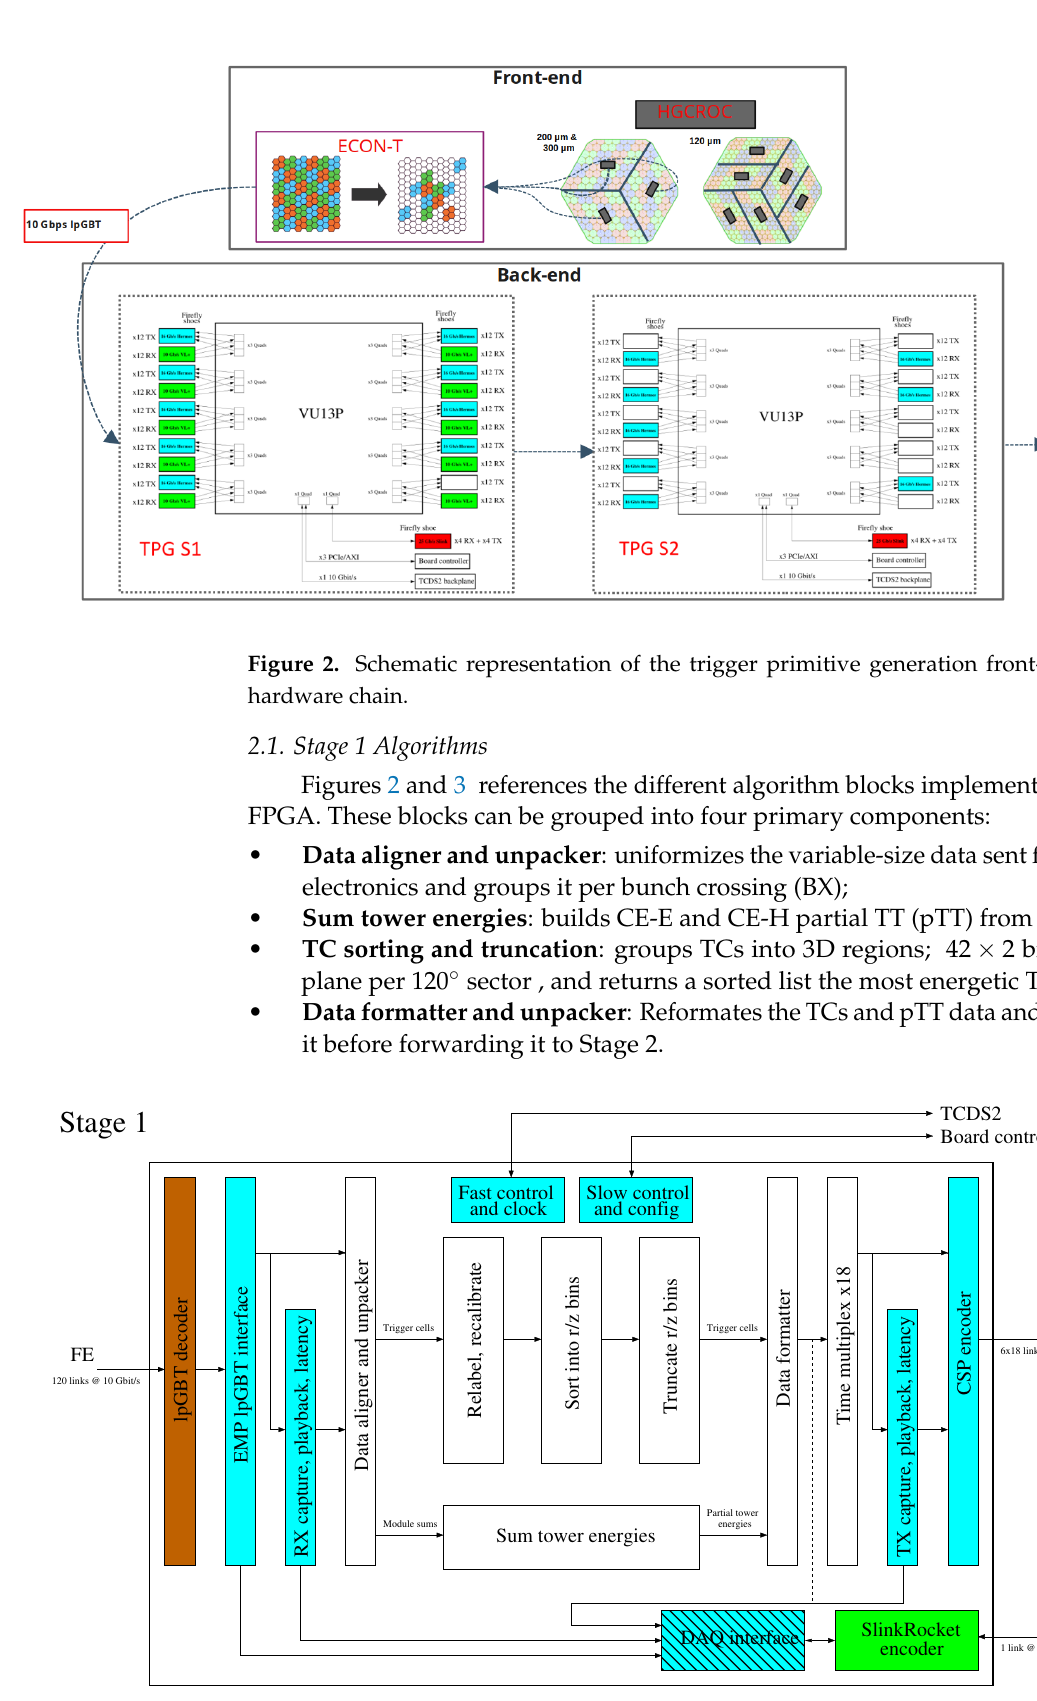
Figure 3. Schematic view of the current HGCAL TPG Stage 1 algorithmic